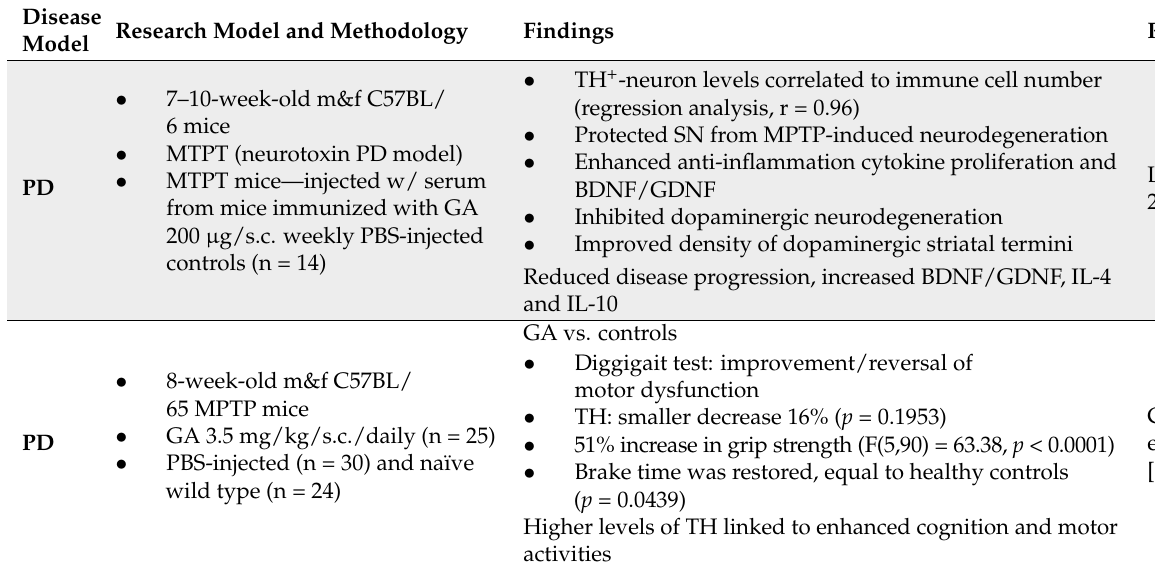
Table 7. Animal Studies Examining Alternative Uses of Glatiramer Acetate in Parkinson’s Disease. Disease Research Model and Methodology Findings Model